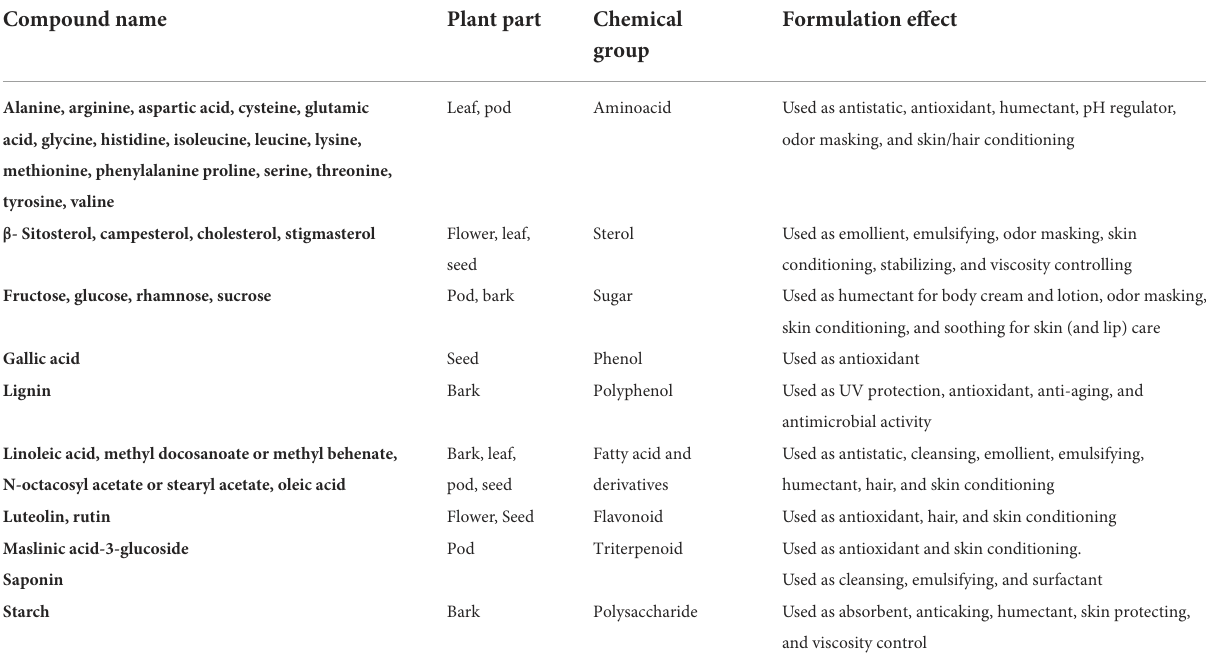
TABLE 2 Formulation effect of the principal compounds in P. cineraria according to